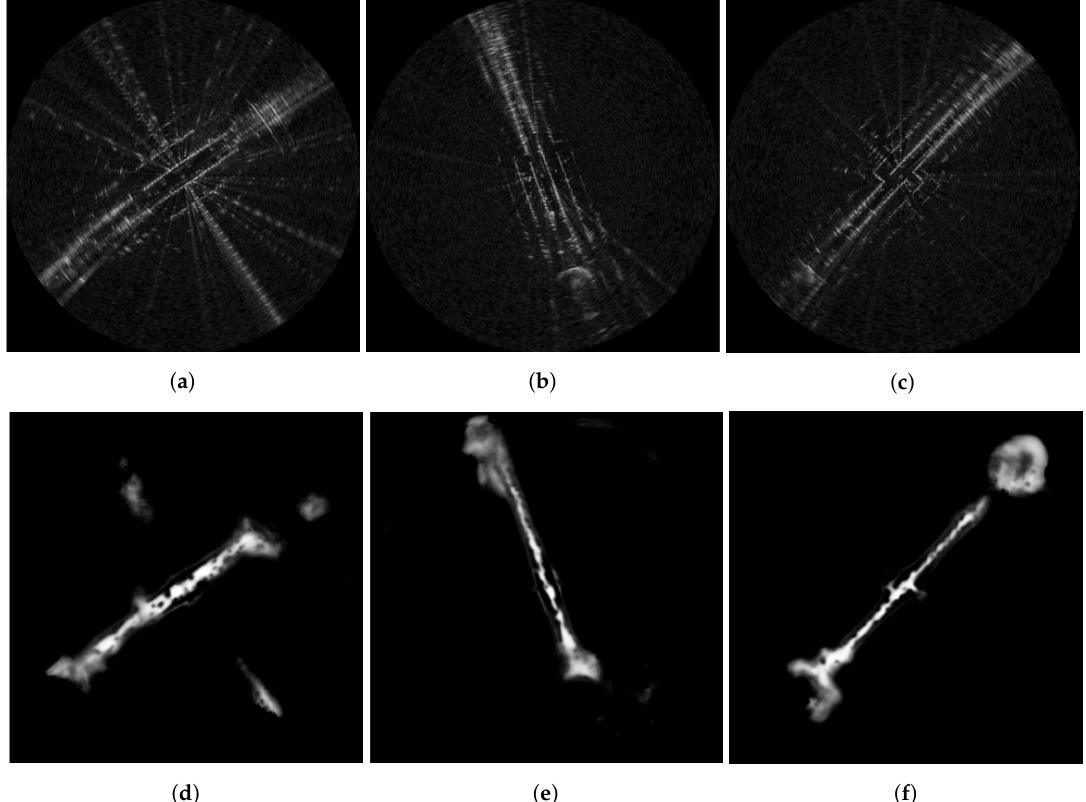
Figure 14. Traversability predictions on straight road segments in the presence of radar artefacts as described in Section 6.1. In ( a , d ), saturation lines (radiating from the vehile location at the centre of the scans). In ( b , e ), ringing effects cause the appearance of duplicate roads. In ( c , f ), occlusion effects obscure the perception of the environment (top right open area). All of these effects present no significant issue to the traversability